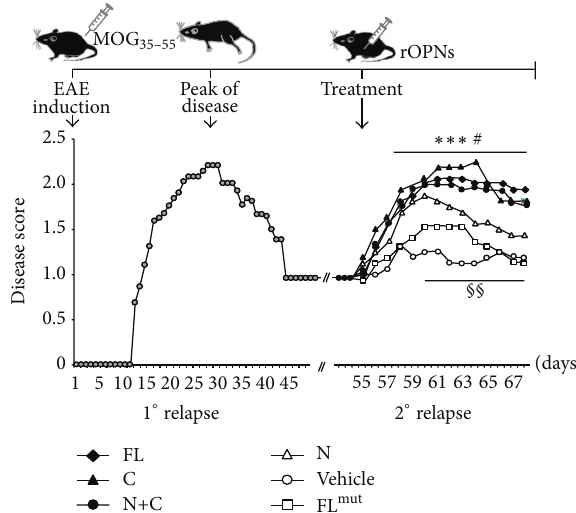
Figure 6: Effect of different forms of OPN on the EAE remission phase. The upper schema depicts the timing of the experiment: 𝑛 = 48 mice were immunized at day 0 with MOG peptide 35–55 to induce EAE. The mice were examined daily for clinical signs of EAE and scored as reported in the lower panel (grey circles). Twenty days after the remission, at day 55 after EAE induction, mice were randomized into different experimental groups and received daily injection of either OPN-FL (black diamonds), OPN-FL mut (white squares), OPN-N (white triangles), OPN-C (black triangles), OPN-C + OPN-N (black circles), or vehicle (white circles). A nonparametric ANOVA test was used for clinical score comparisons ( ∗∗∗ 𝑝 < 0.001 PBS versus OPN-FL, OPN-C, and OPN-N + OPN-C; # 𝑝 < 0.05 PBS versus OPN-N; §§ 𝑝 < 0.01 OPN-C versus OPN-N and versus OPN-FL mut